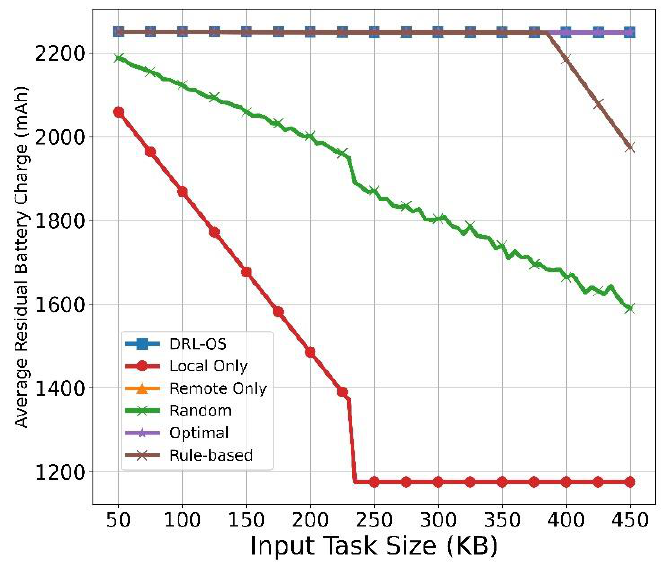
Figure 9. Average residual battery vs. input task size.